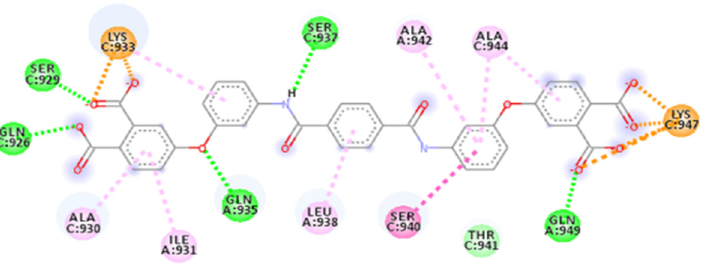
Figure 8. Calculated 2D interactions of ZINC000097996131 in complex with SARS-CoV-2’s HR1 domain.